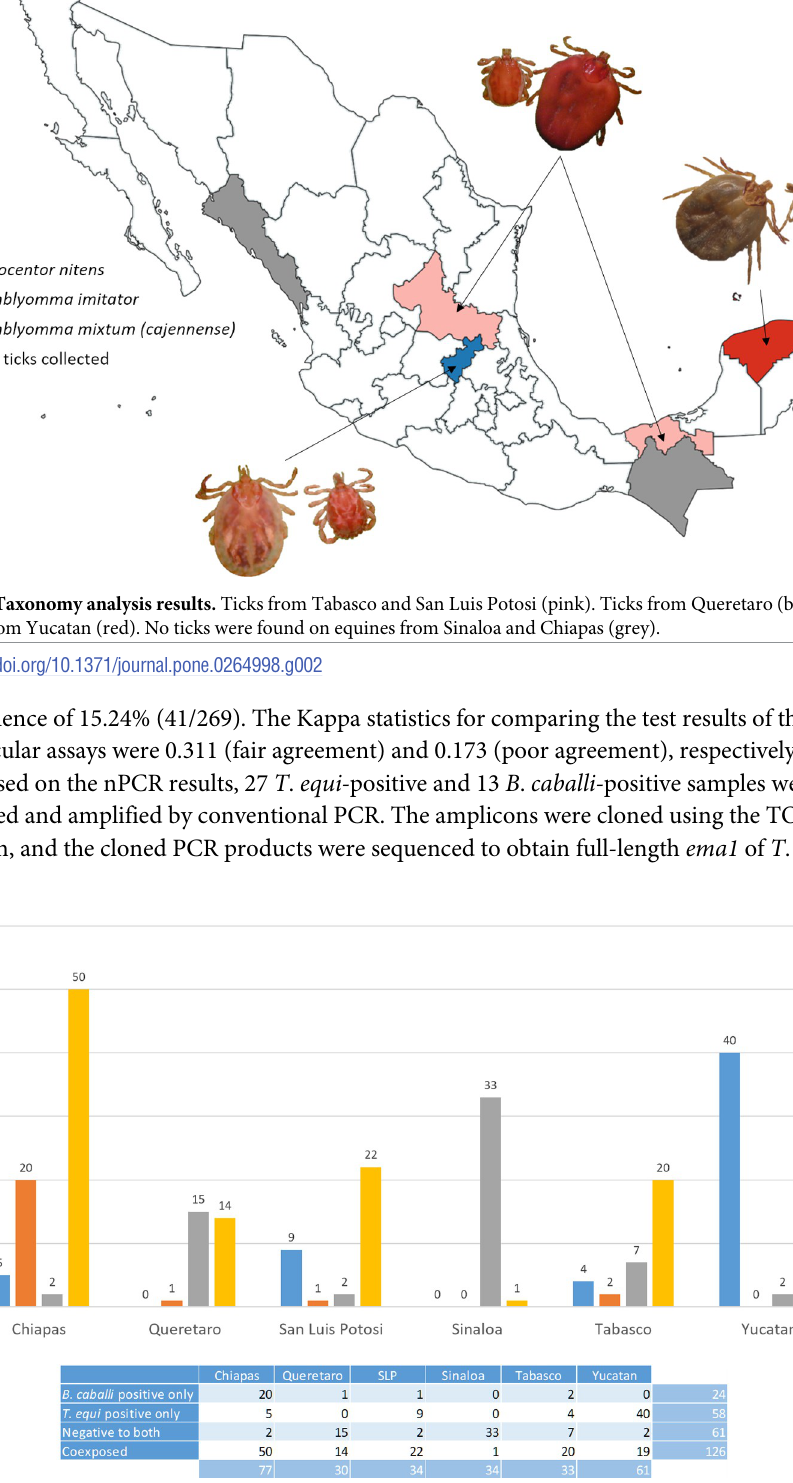
Fig 3. Antibody detection by cELISA. Positive samples to T . equi (blue bars). Positive samples to B . caballi (orange bars). Negative samples (grey bars). Coexposed (yellow bars). The table section shows a summary of the results.